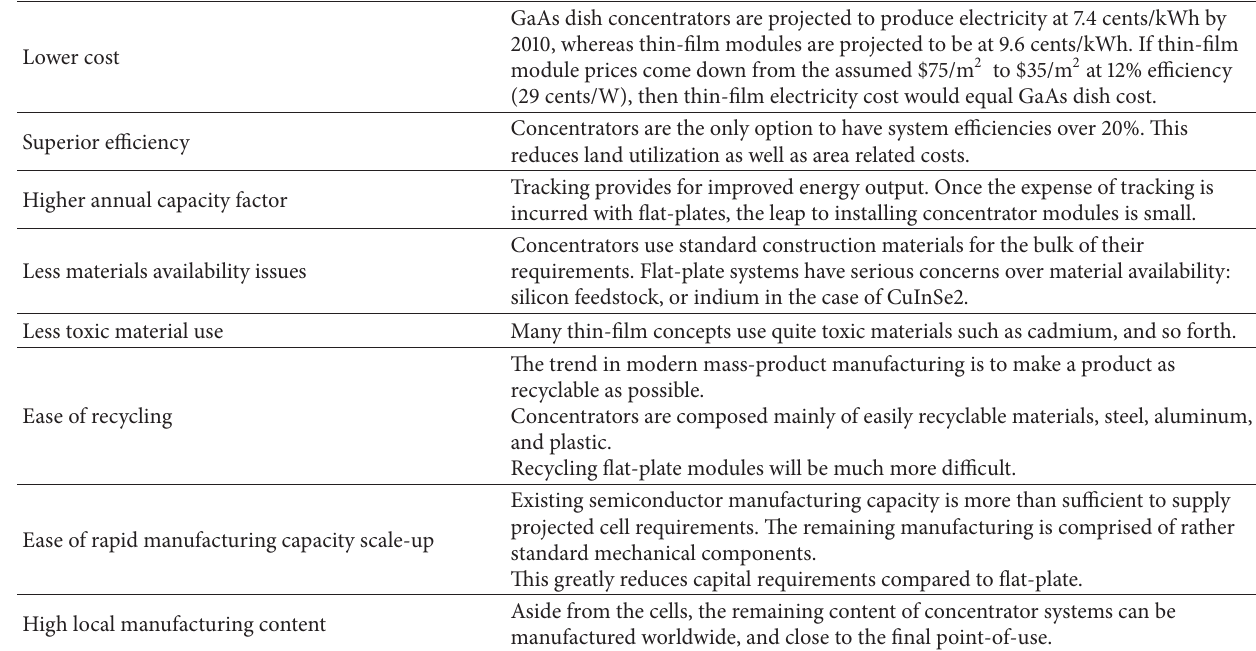
Table 1: Advantages of concentrating over flat-plate systems for large PV installations [22].